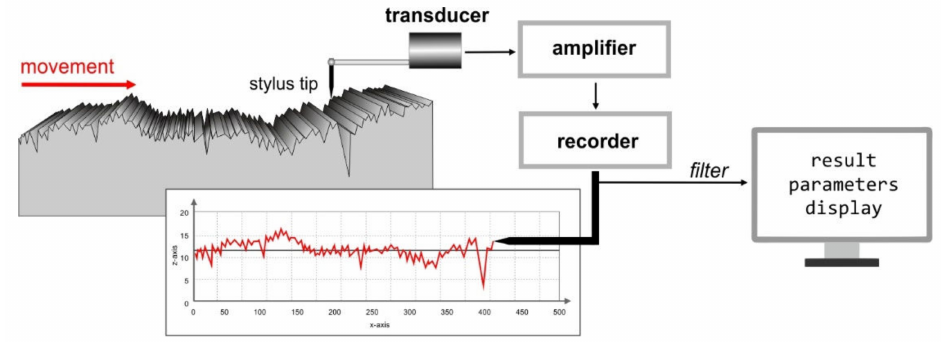
Figure 2. Principle of surface roughness measurement using the contact